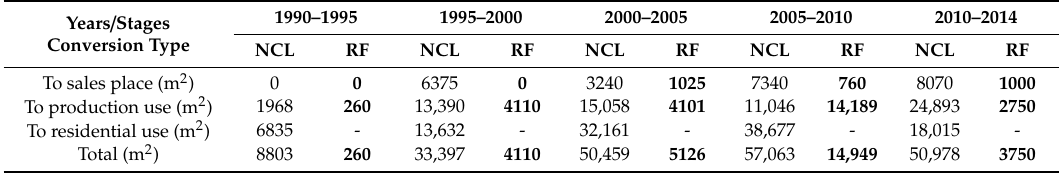
Table 2. The conversion of non-construction land to residential land in